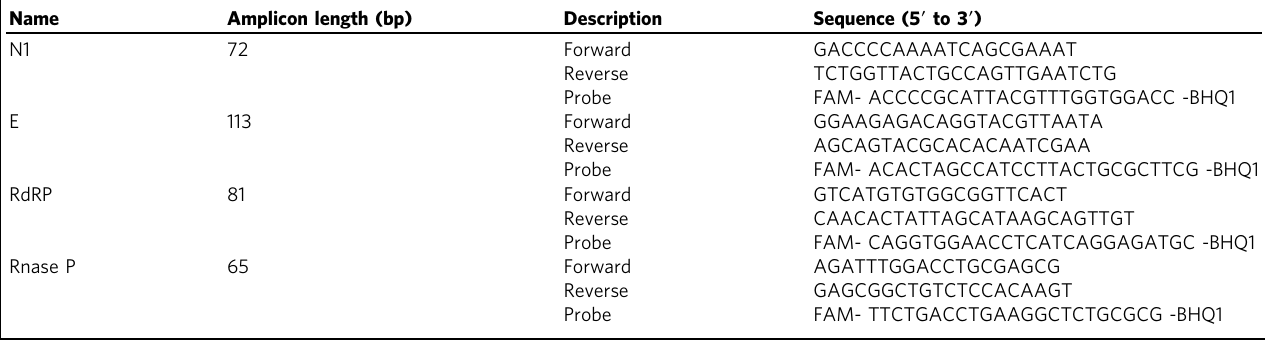
Table 1 Primers and probes used for SARS-CoV-2